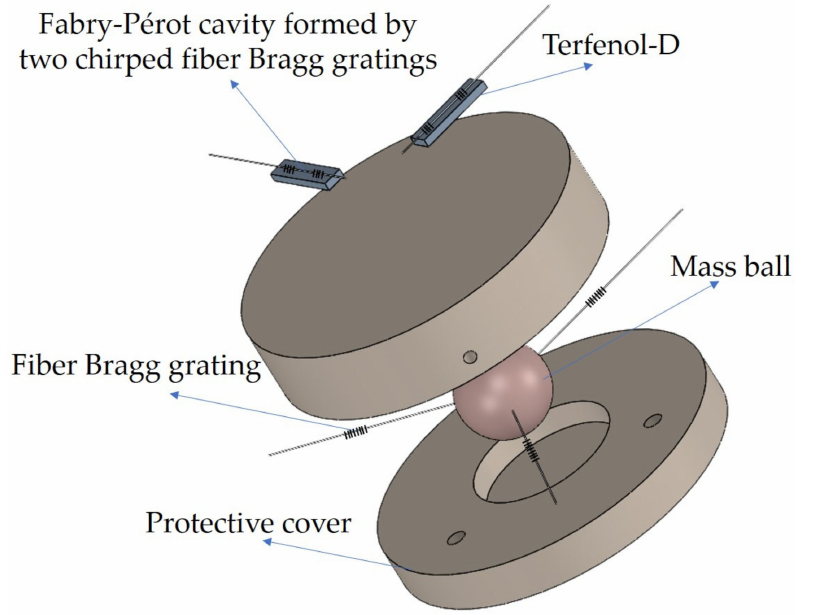
Figure 1. Overall schematic diagram of the all-fiber optical sensor combined with FBG and